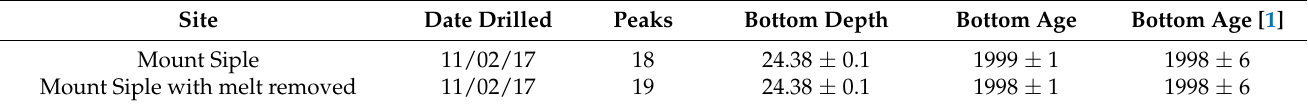
Figure 2. ( a ) Complete grey-scale record for the Mount Siple core (blue) and the 10,000 point moving mean of the grey-scale (red) generated from the original images. The grey bars indicate the counted peaks. ( b ) As in a, but the melt layers and breaks have been removed. Table 1. Summary table of the core depth and bottom ages for Mount